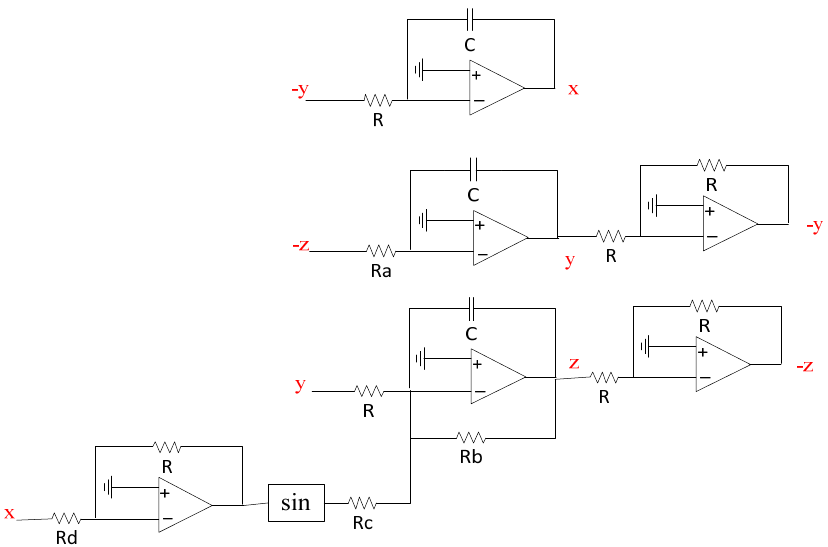
Figure 12. Circuit schematic diagram of the system (1).